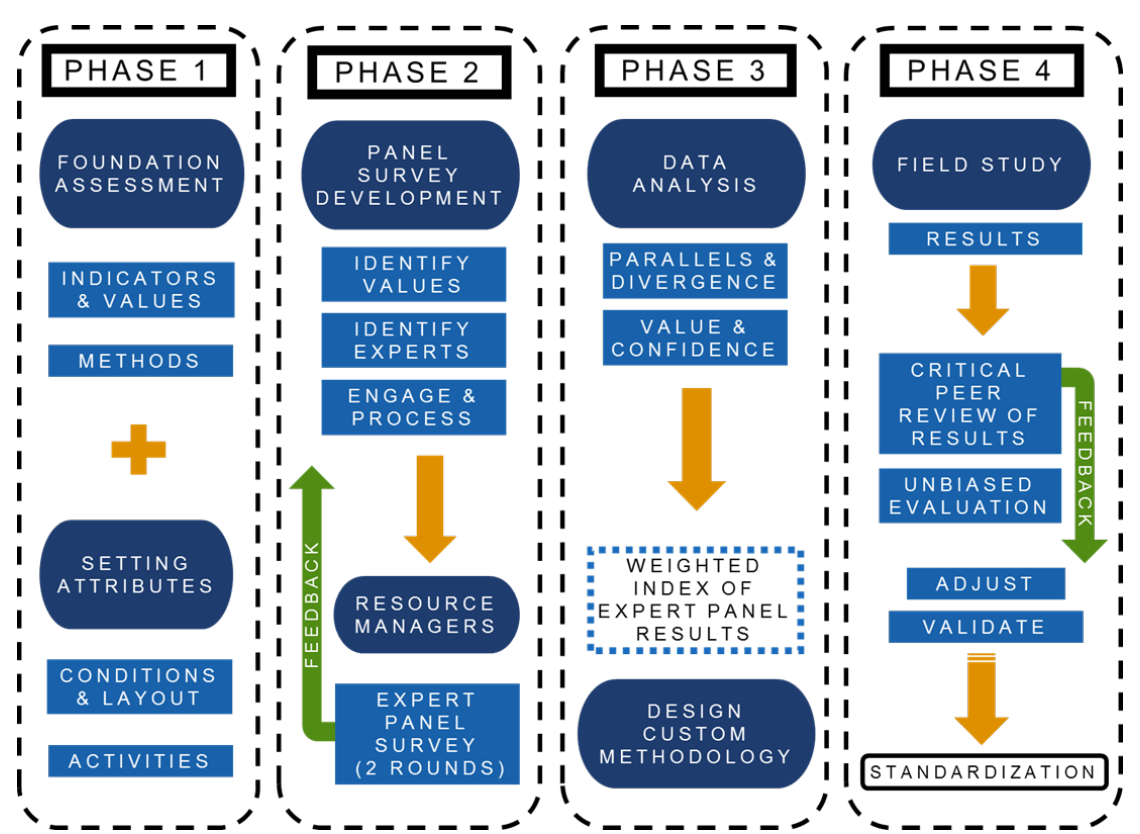
Figure 1. Conceptual diagram of a visitor monitoring process that can be applied to aquatic protected areas. This process is adopted from the work of Burns et al. [107] (2020), which outlines the process as it can be applied to National Marine Sanctuary sites within the U.S. The process covers four phases, from foundational assessment to application to field study and data collection. Critically, the incorporation of expert panel input and analysis of potential methods is included with the option to generate feedback and adapt to changing visitor monitoring demands.